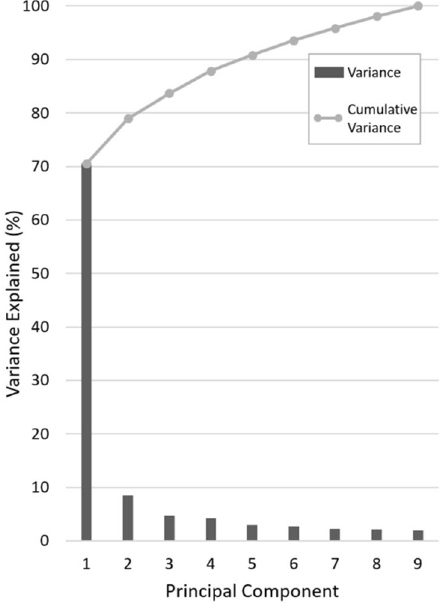
Figure 2. Variation and cumulative variation represented by principal component number for the statistical bone shape and cartilage thickness model.